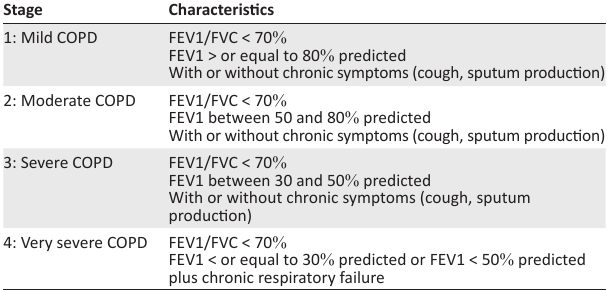
TABLE 1: ‘GOLD’ classification of COPD severity (Global Initiative for Chronic Obstructive Lung Disease 2015). Stage